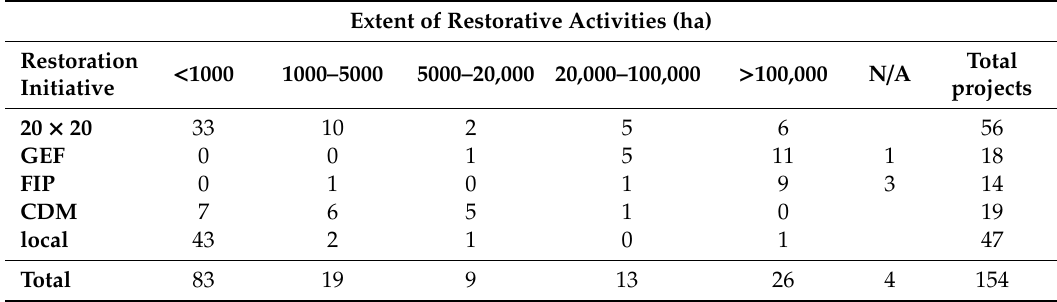
Table 3. Extent of restorative activities within the projects, summarized for each restoration